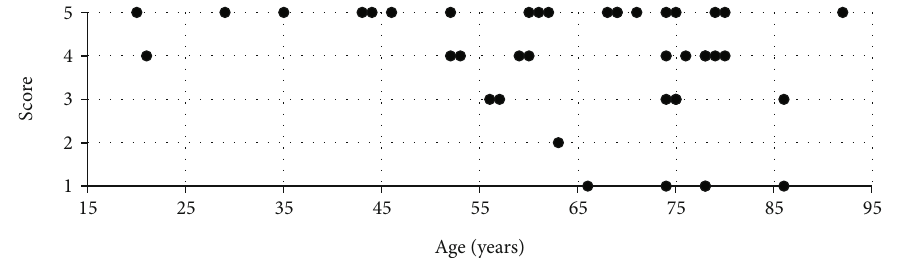
Figure 3: Scatterplot of patients ’ attitude against the telepresence robot divided on age ( n = 42 ). Axes are patients ’ age and willingness to be seen by the telepresence robot at a future visit on a 1-5 scale (where 1 = “ strongly disagree ” and 5 = “ strongly agree ”